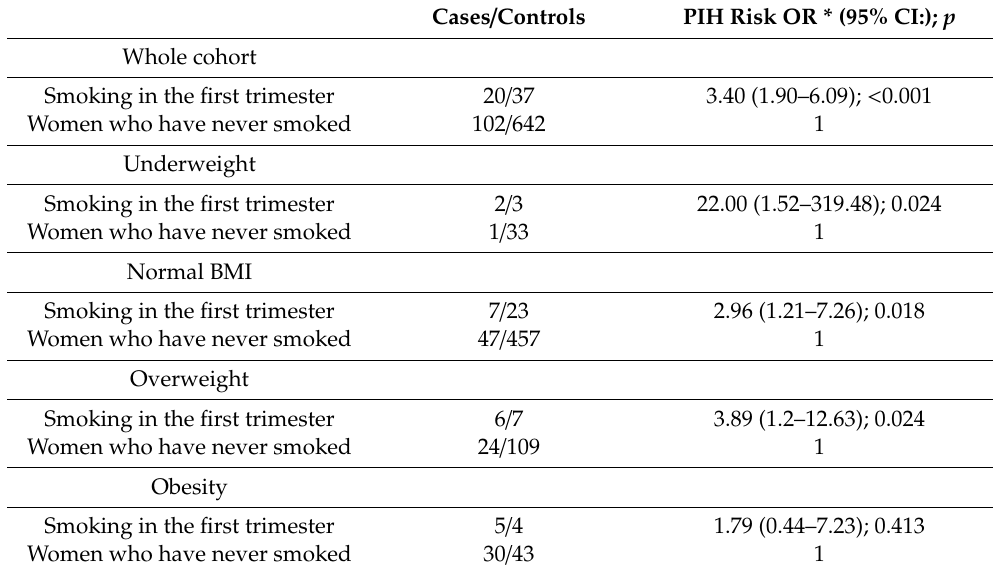
Table 4. The odds ratios of pregnancy-induced hypertension (PIH) for smoking in the first trimester, after dissection into pre-pregnancy BMI